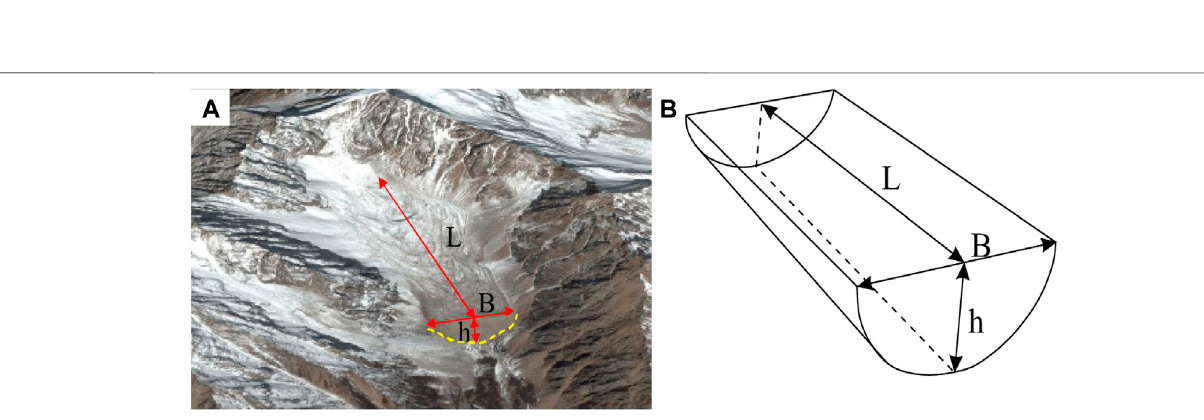
Frontiers in Earth Science |